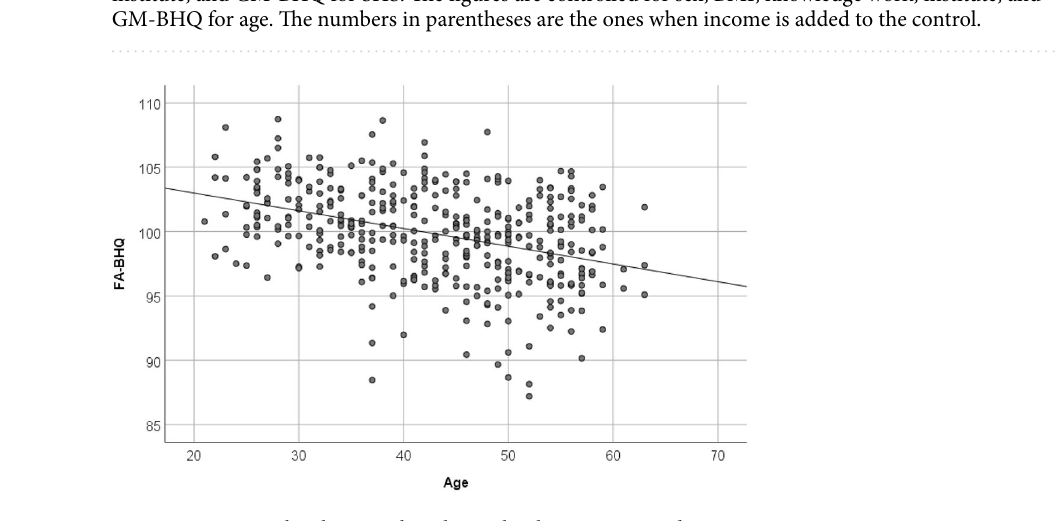
Figure 4. Scatter plot showing the relationship between age and FA-BHQ.